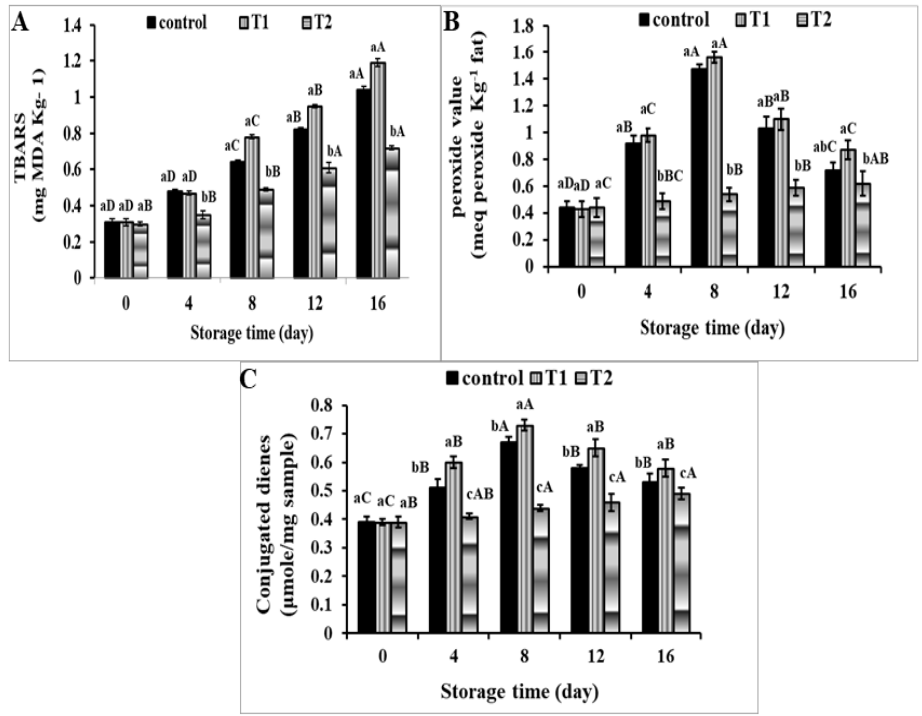
Figure 4. Changes in TBARS (mg MDA Kg –1 ) ( A ), peroxide value (meq peroxide Kg –1 fat) ( B ), and conjugated dienes ( µ mole/mg of sample) ( C ) in meatball samples with incorporated cod liver oil microcapsules during storage at 4 ± 1 ◦ C. Error bars represent standard deviation, (n = 3). T1: free cod liver oil direct addition, T2: encapsulated cod liver oil. Different superscripts of (a – c) lowercase letters indicate significant differences at p < 0.05 between treatments at each storage time. Different superscripts of (A, B) uppercase letters indicate significant differences at p < 0.05 of each sample over the storage period.